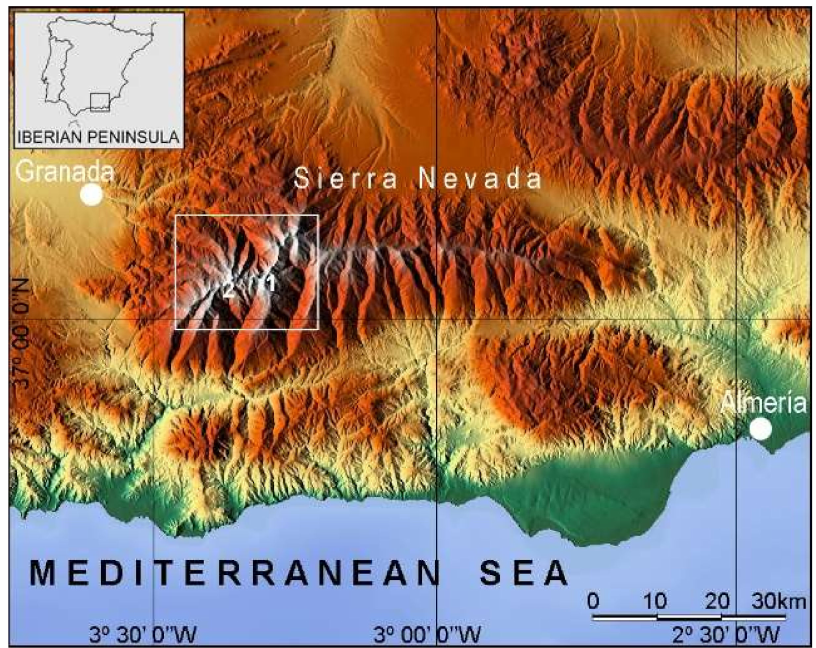
Figure 1. Geographic situation of the Sierra Nevada Massif: the white box shows the area where the studied water-bodies are located. Numbers 1 and 2 indicate the Mulhac é n and Veleta peaks.